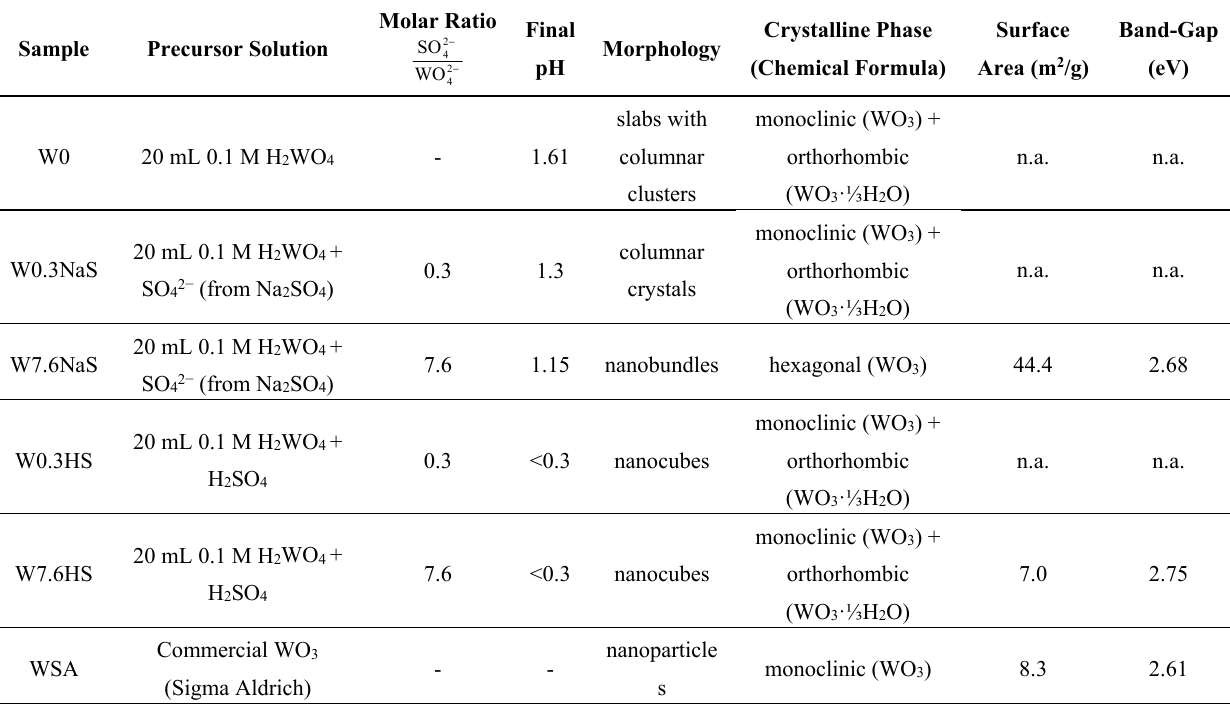
Table 1. Selected synthesis parameters and characteristics for the different WO 3 photocatalysts. Included are the characteristics for commercial Sigma Aldrich WO 3 (WSA). Molar Sample Precursor Solution